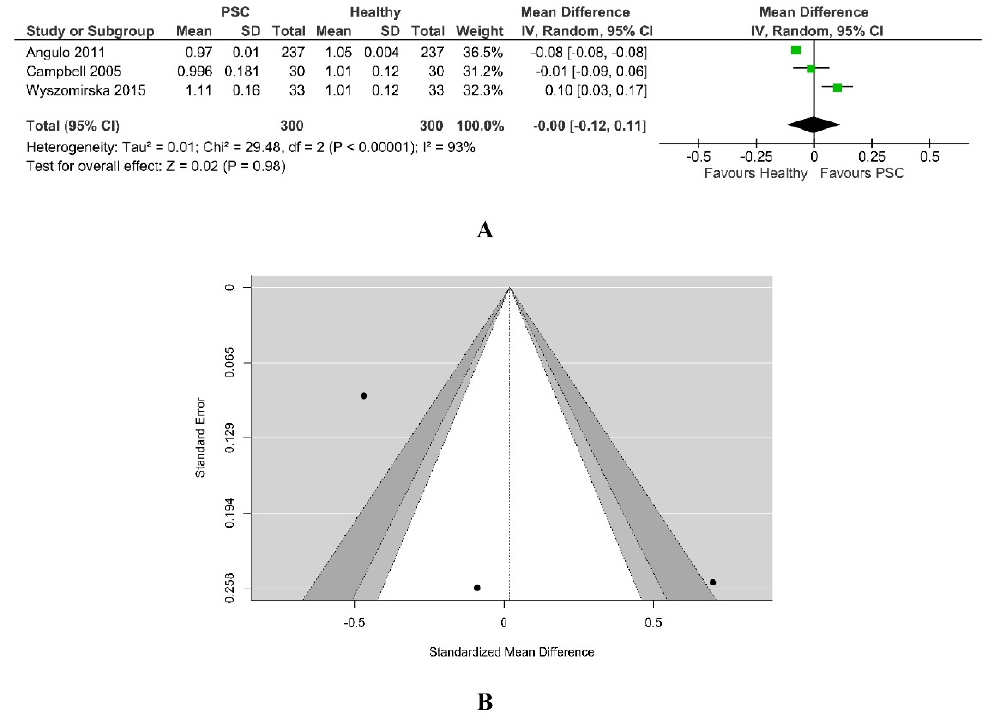
Figure 2. ( A ) Forest plot assuming a random-effects model for BMD-LS PSC vs. Healthy. ( B ) Funnel plot demonstrating publication bias assessment in model for BMD-LS PSC vs. Healthy [18,19,34].